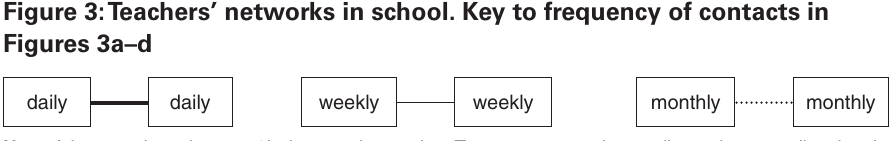
Figure 3: Teachers’ networks in school. Key to frequency of contacts in